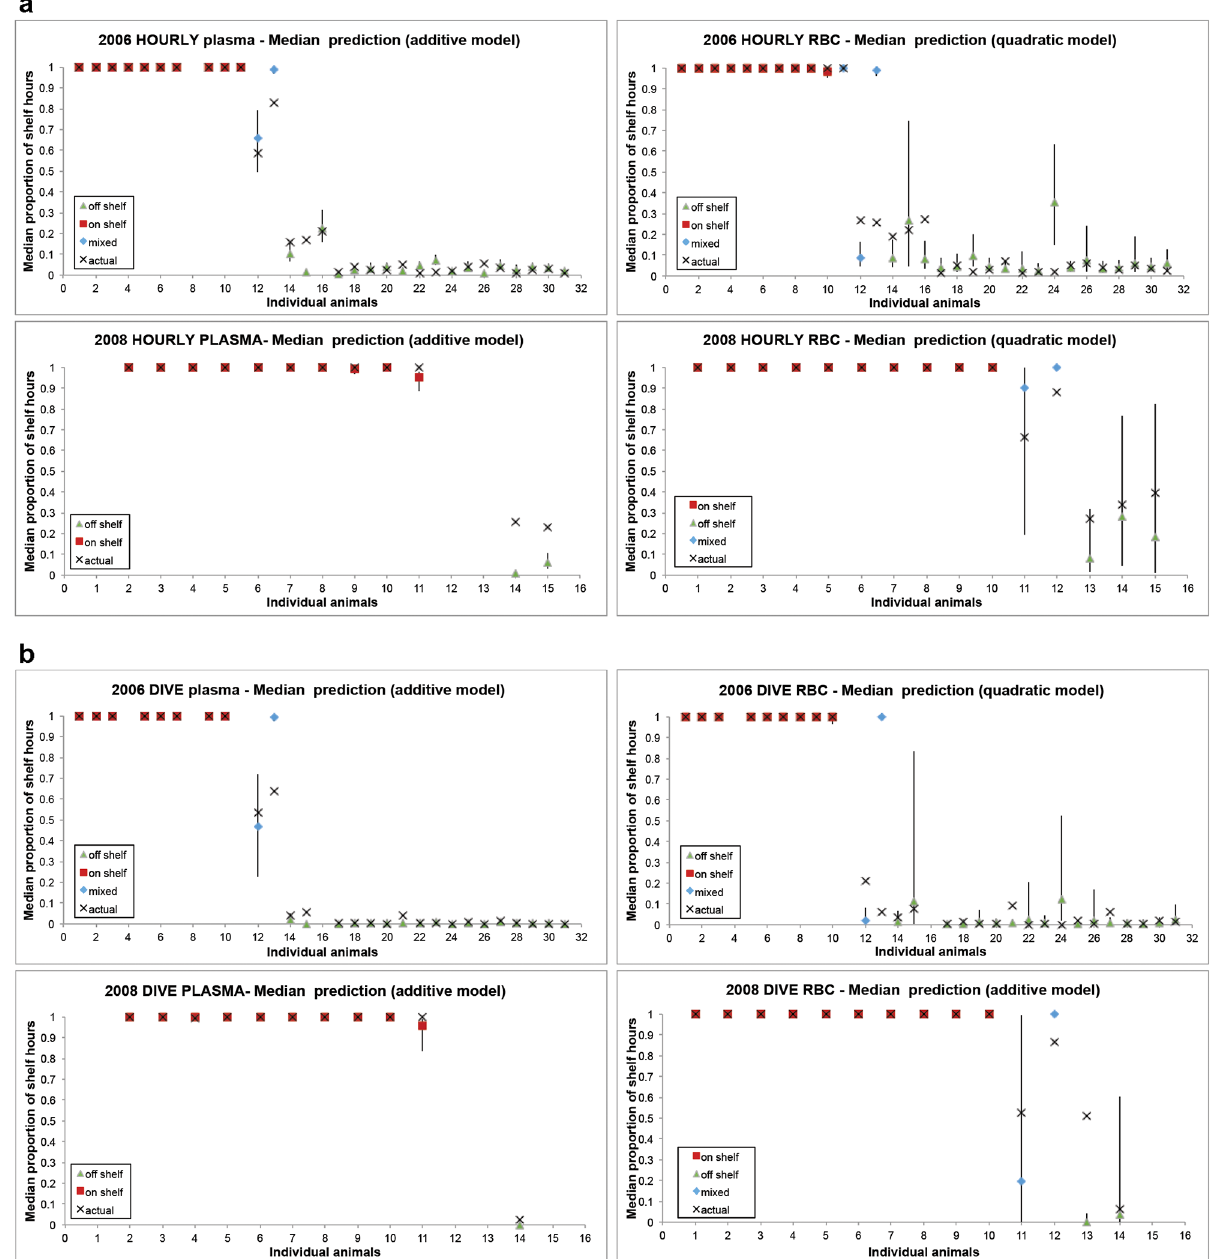
Fig 5. Predicted and actual proportion of hours (a) and dives (b) individual northern fur seals spent on the shelf with 95% CI (from generalized linear mixed model) for red blood cells & plasma). Red, green and blue lines indicate animals categorized as on-, off-, or in mixed-shelf foragers,